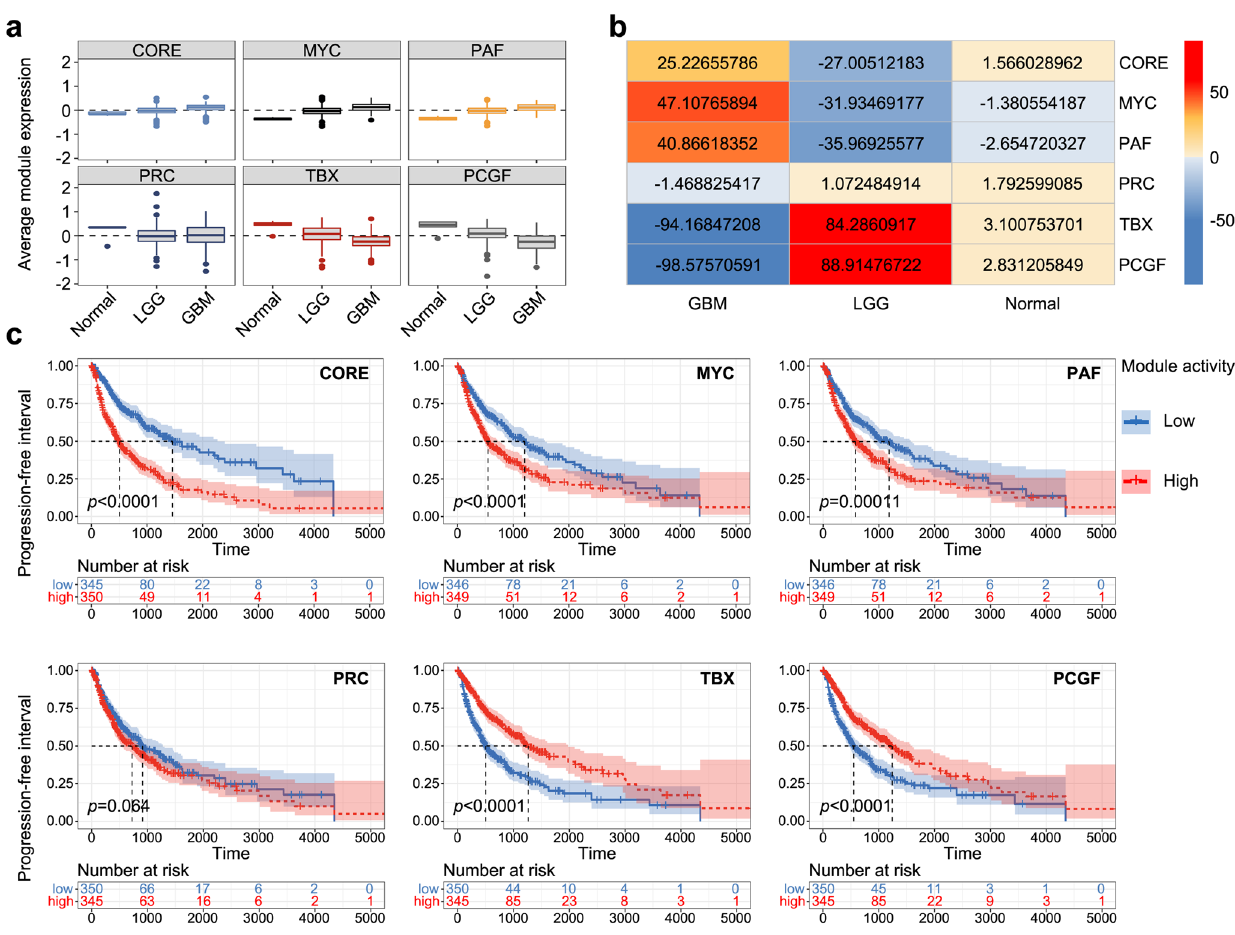
Fig. 8 Association of module activity with tumour subtype and prognostic outcome in gliomas. a The boxplots show the gene expression of each module in normal, LGG and GBM samples. Boxes show interquartile range, whiskers show fi xed multiples of interquartile range and center line shows average gene expression values (log 2 ). LGG, low-grade gliomas. GBM, glioblastoma multiform. b Enrichment patterns of modules in normal, LGG and GBM group samples. Numbers indicate the enrichment signi fi cance (-log2 ( p -value)) of module genes within each sample group. Red (positive value) indicates enrichment for high-expression, and blue (negative value) indicates enrichment for low-expression. Colour intensity corresponds to the -log2 ( p -value). c Kaplan – Meier analyses of the progression-free interval in patients. Patients with high module activities (50% cut-off) are labelled red, whereas patients showing low module activities (50% cut-off) are labelled blue. p values are calculated using the log-rank